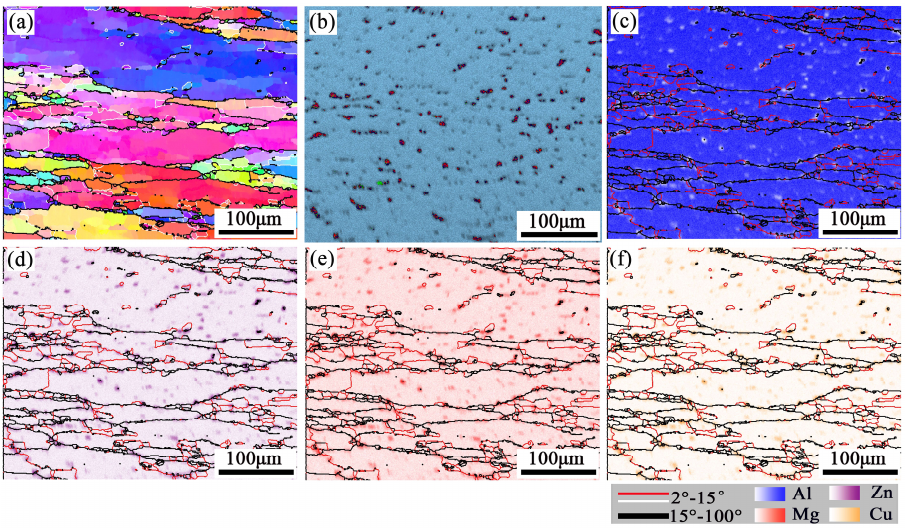
Figure 9. ( a ) EBSD-IPF map ( b ) EDS map and energy spectrum analysis maps: ( c ) Al, ( d ) Zn, ( e ) Mg, ( f ) Cu at 440 °C/0.001 s −1 .